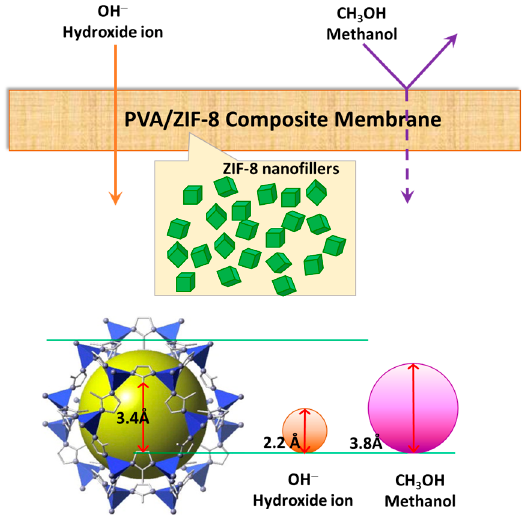
Figure 1. Illustration showing polyvinyl alcohol/zeolitic imidazolate framework-8 (PVA/ZIF-8) composite membrane with molecular screening effect: easy penetration of smaller hydroxide ions and suppression of larger methanol molecules. The methanol may transfer through the ZIF-8 external surface but has a limited diffusion rate in PVA matrix.